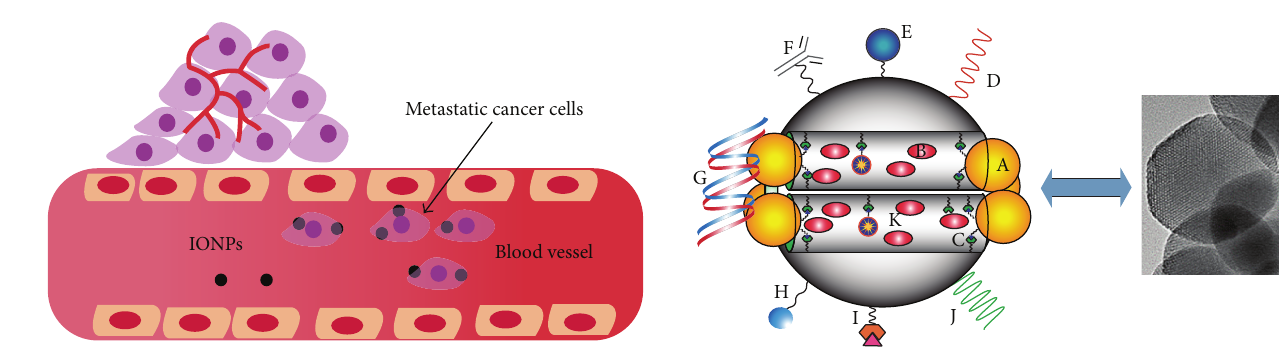
Figure 3: Schematic representation of the capability of IONPs for detecting metastatic cancer cells.